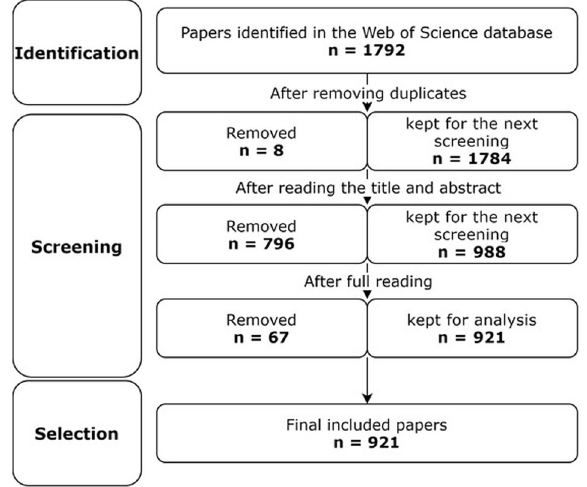
Fig. 1 Stages of implementation. Identi fi cation, screening and selection of publications. * n =